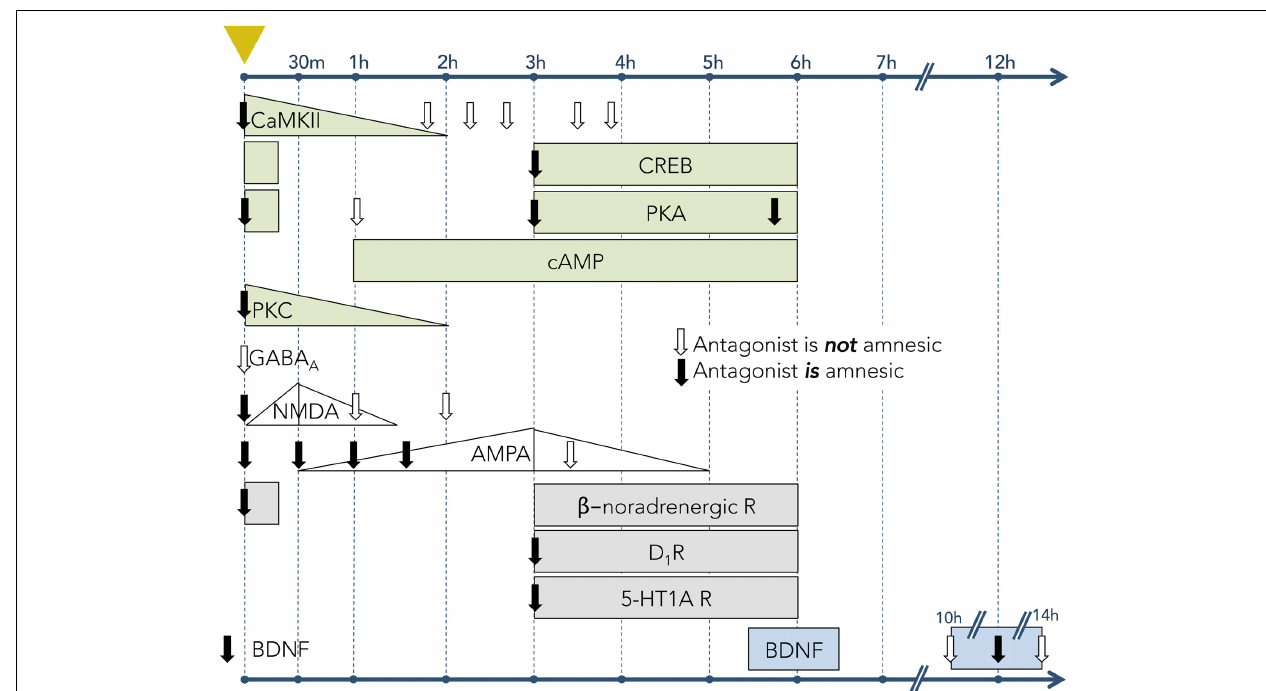
FIGURE 3 | Timecourses of activity for learning-associated molecular mechanisms in hippocampal tissue following one-trial inhibitory avoidance (IA) training. Leftmost dashed vertical line (marked with yellow triangle) denotes the time of IA conditioning. Subsequent vertical lines denote timepoints following the trial. Rows correspond to particular mechanisms (signaling molecule, receptor, or neuromodulator). Downward-pointing arrows indicate timepoints when antagonists to the corresponding receptor or signaling pathway were infused into the hippocampus; solid arrows denote that the antagonists had an amnesic effect on LTM (when tested 24–48h after conditioning); open arrows indicate no amnesic effect on LTM. Filled shapes denote the experimentally-measured expression levels of receptors or signaling molecules. Increasing or decreasing levels are depicted when known; rectangles depict measurable levels when relative abundances were not measured. Light green shapes represent intracellular signaling pathways,